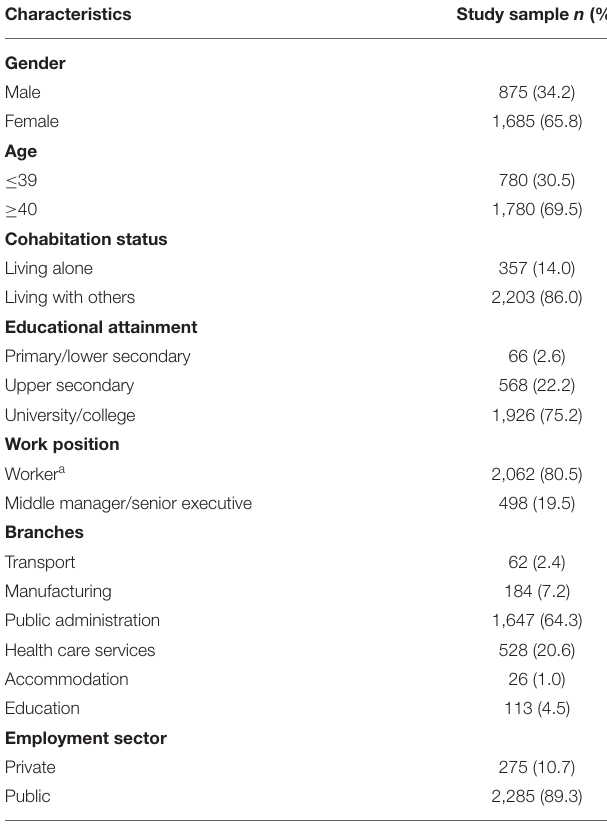
TABLE 1 | Study sample characteristics ( N =